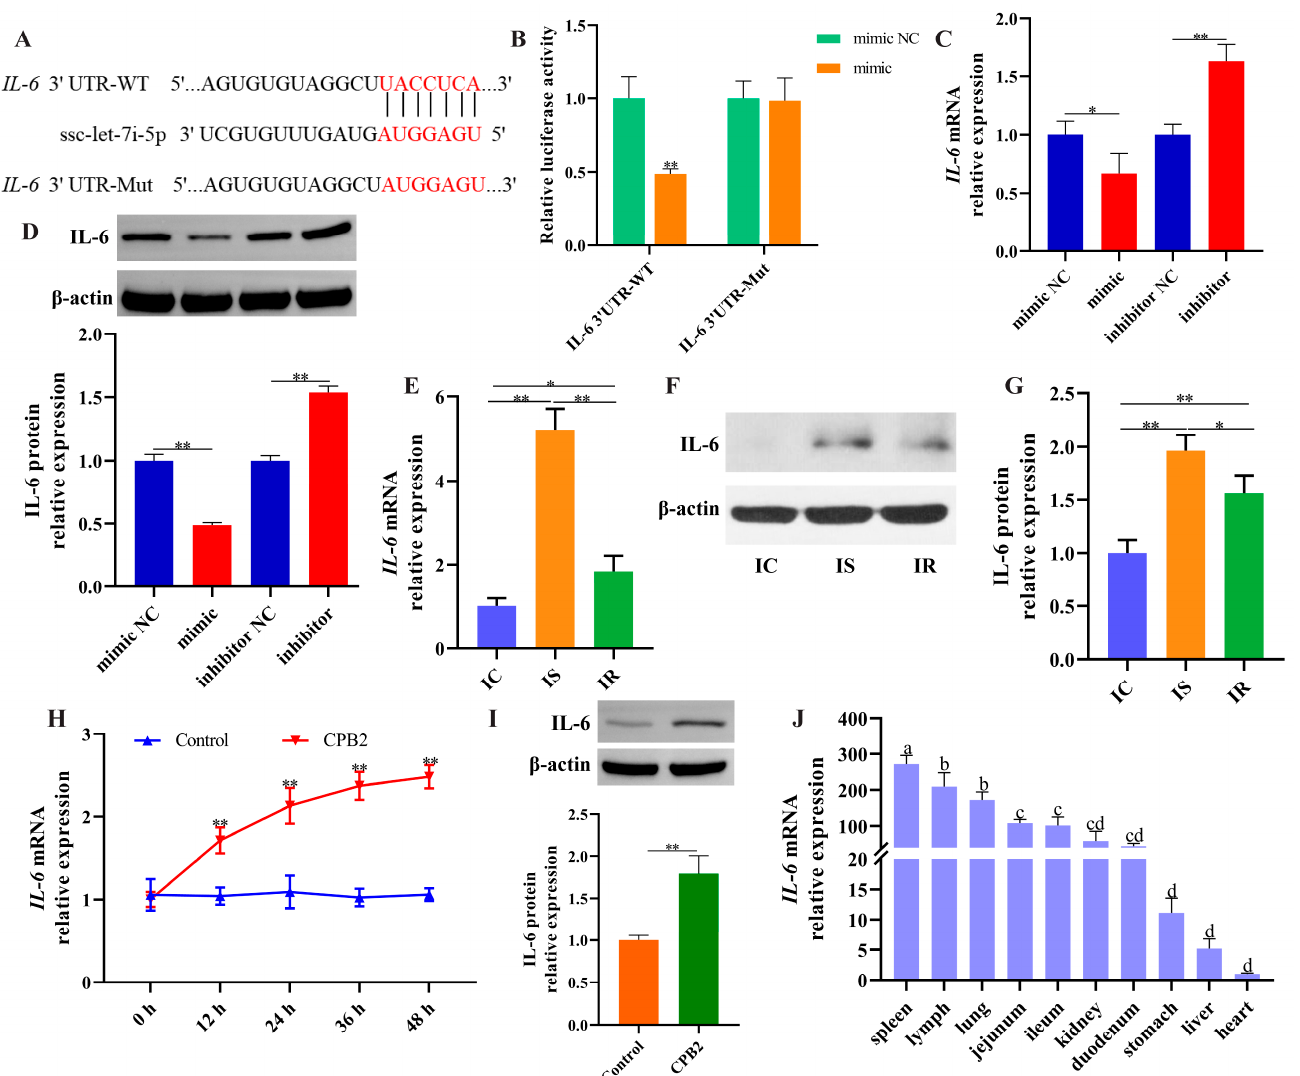
Figure 8. ssc-let-7i-5p directly targeted IL-6. ( A ) Binding sites of ssc-let-7i-5p to IL-6 . ( B ) Fluorescence activity through dual-luciferase reporter assay. ( C , D ) IL-6 mRNA and protein expression after ssc-let-7i-5p overexpression and knockdown by RT-qPCR and Western blot. ( E – G ) IL-6 mRNA and protein expression in IC, IS and IR groups by RT-qPCR and Western blot. ( H , I ) IL-6 mRNA and protein expression in CPB2 toxin-infected IPEC-J2 cells via RT-qPCR and Western blot. ( J ) IL-6 expression in different tissues of healthy piglets by RT-qPCR. Different lowercase letters indicate highly significant differences between groups ( p < 0.01). * p < 0.05, ** p < 0.01.